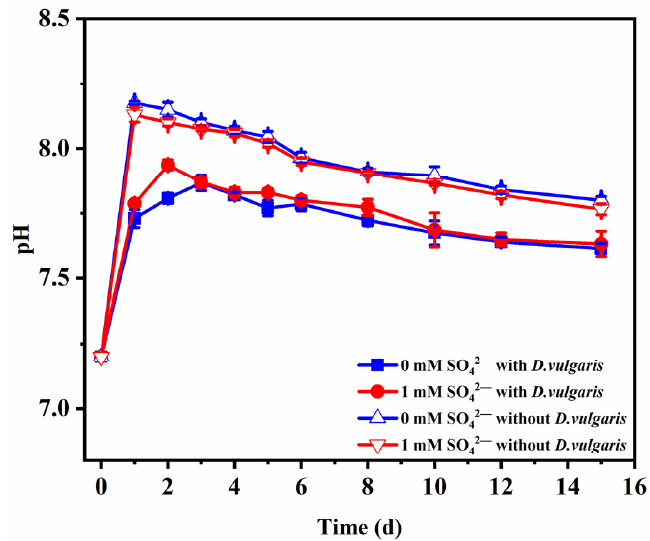
Figure 7. Variation of pH value in sediment experiment. Error bars indicate standard deviation of triplicates.